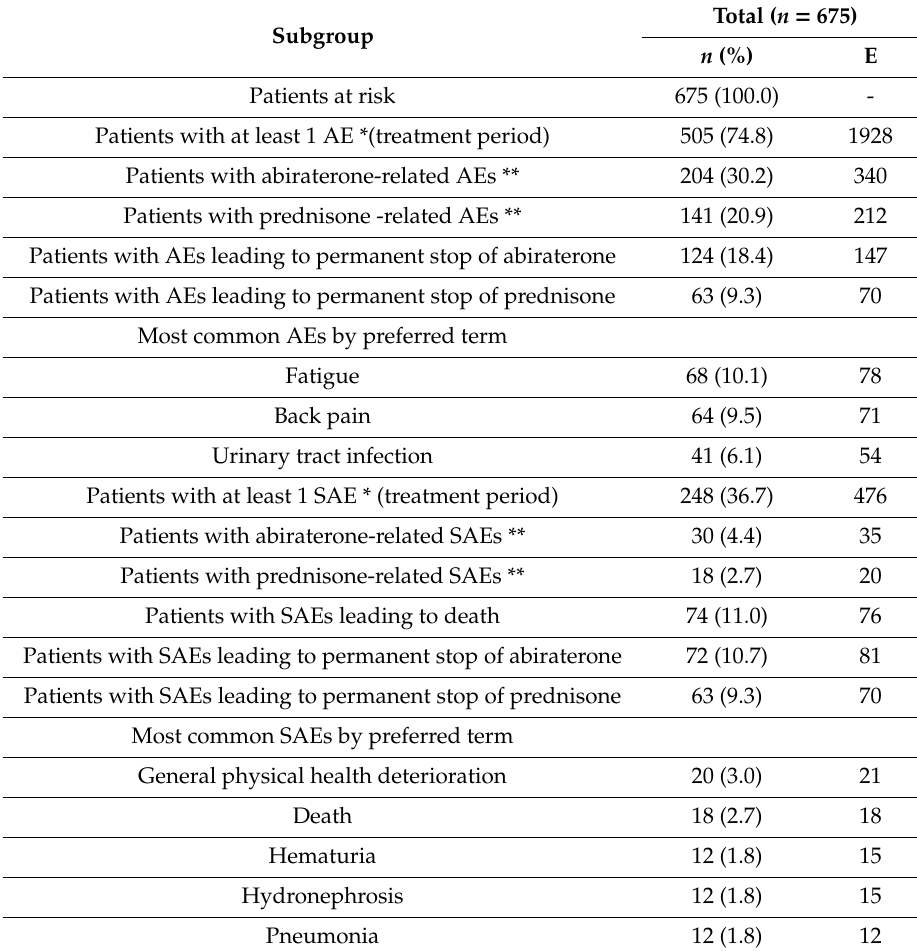
Table 5. Adverse